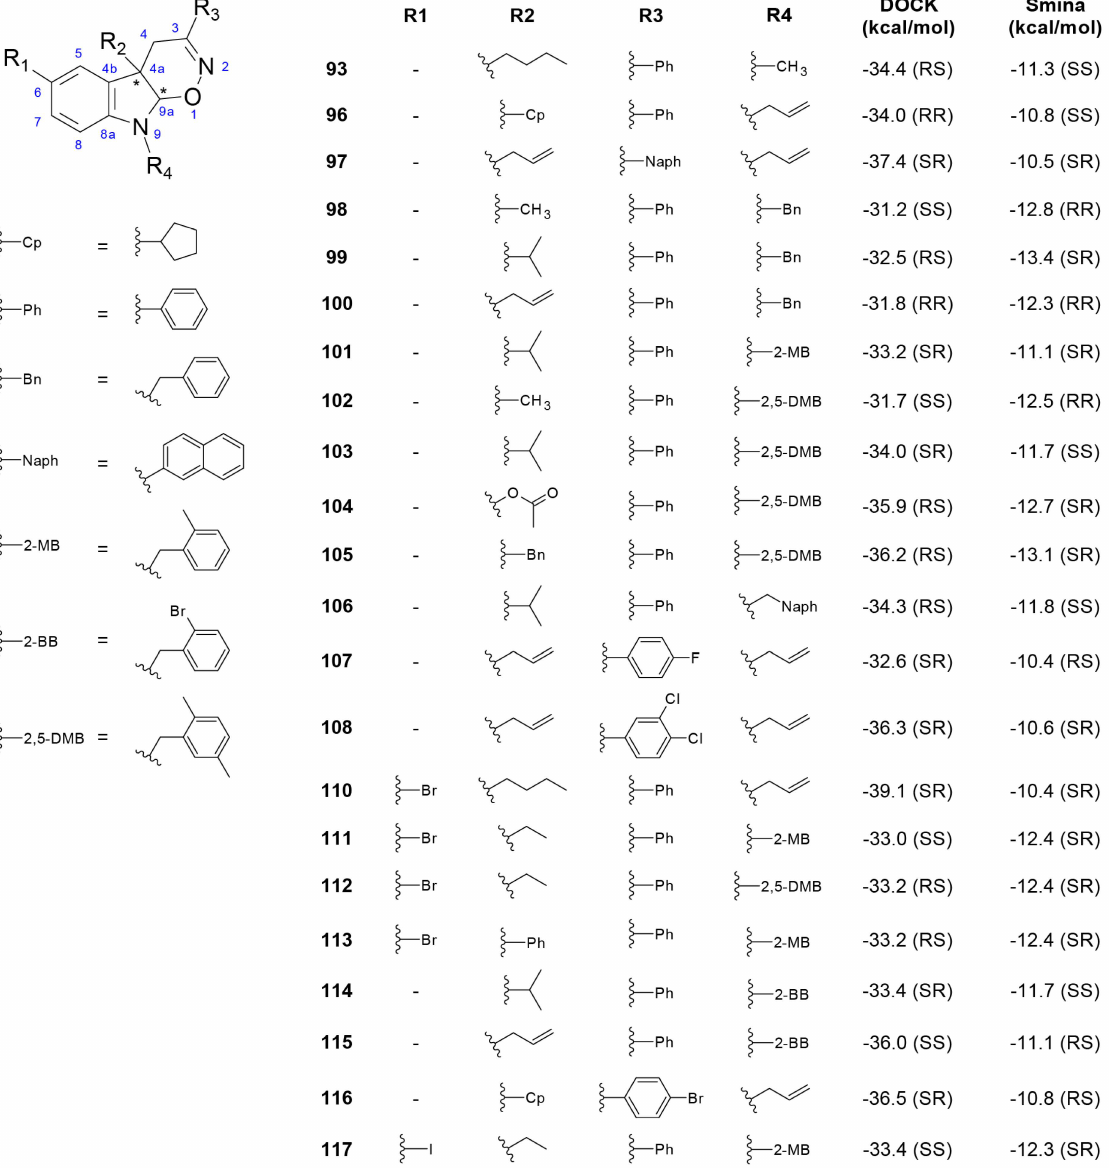
Figure 6. Compounds from L4 library with the most favorable energy scores. The compounds were selected according to the cut-off values defined in Section 3.1. All the selected compounds have at least one stereoisomer meeting the selection criteria. Position of stereocenters in the tetrahydro-1,2-oxazino indole (TOI) nucleus is indicated with “*”. Only the value for the stereoisomer with the most favorable, lowest, energy score is shown for each compound and program. Cp: